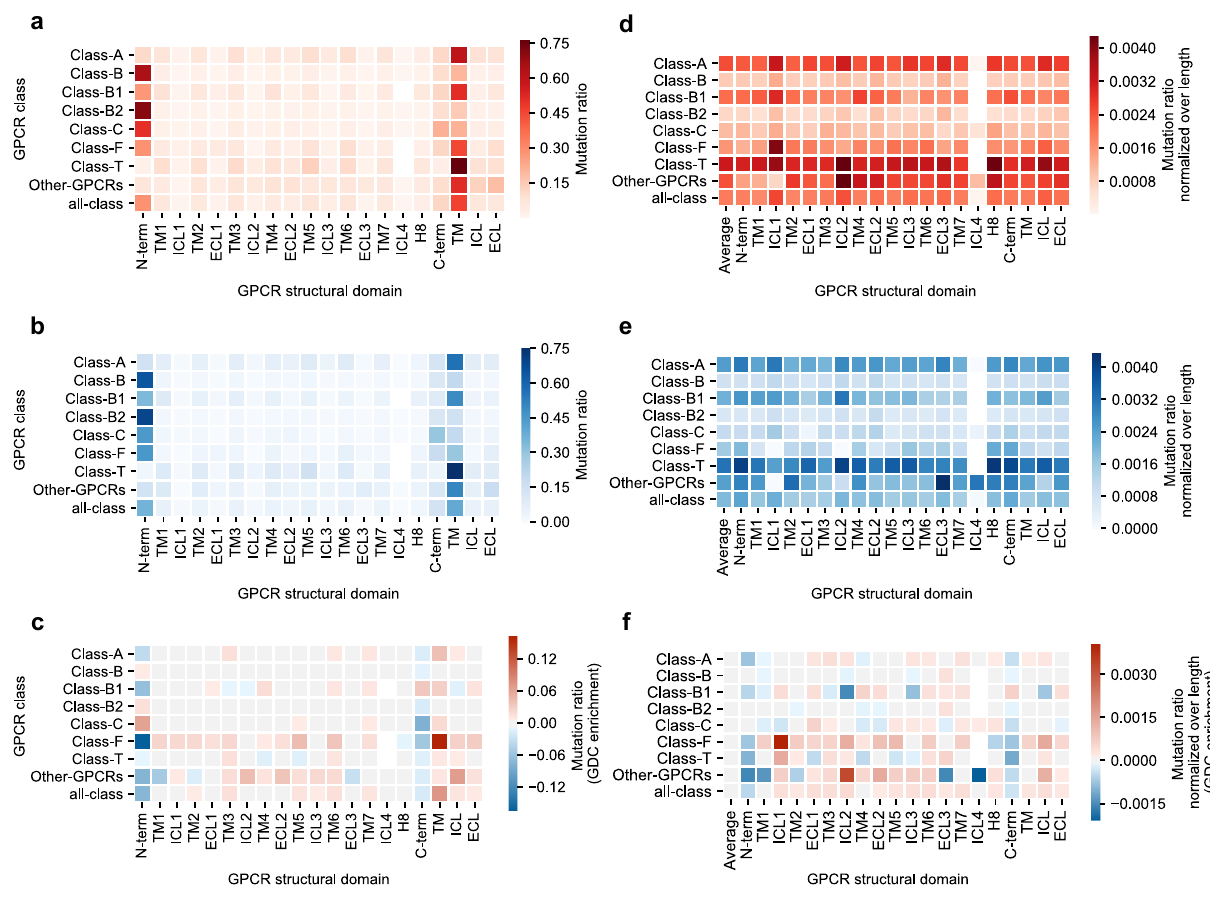
Figure 2. Distribution of mutation frequencies per GPCR structural domain. ( a ) Mutation ratio found in each structural domain in the GDC dataset for GPCRs in all classes combined and independently. ( b ) Mutation ratio found in each structural domain in the 1000 Genomes dataset for GPCRs in all classes combined and independently. ( c ) Mutation ratio enrichment in the GDC dataset over the 1000 Genomes dataset. ( d ) Mutation ratio normalized over average domain length found in each structural domain in the GDC dataset for GPCRs in all classes combined and independently. ( e ) Mutation ratio normalized over average domain length found in each structural domain in the 1000 Genomes dataset for GPCRs in all classes combined and independently. ( f ) Length-normalized mutation ratio enrichment in the GDC dataset over the 1000 Genomes dataset. “TM”, “ICL” and “ECL” represent the (normalized) mutation ratios in aggregated domains. In panels ( d – f ), “Average” represents the average ratio considering a domain as the whole protein. In panels ( a ) and ( d ), a darker shade of red represents a higher (normalized) mutation ratio in the GDC dataset. In panels ( b ) and ( e ), a darker shade of blue represents a higher (normalized) mutation ratio in the 1000 Genomes dataset. In panels ( c ) and ( f ), a darker shade of red represents a higher (normalized) mutation ratio enrichment towards the GDC dataset, while a darker shade of blue represents a higher (normalized) mutation ratio enrichment towards the 1000 Genomes